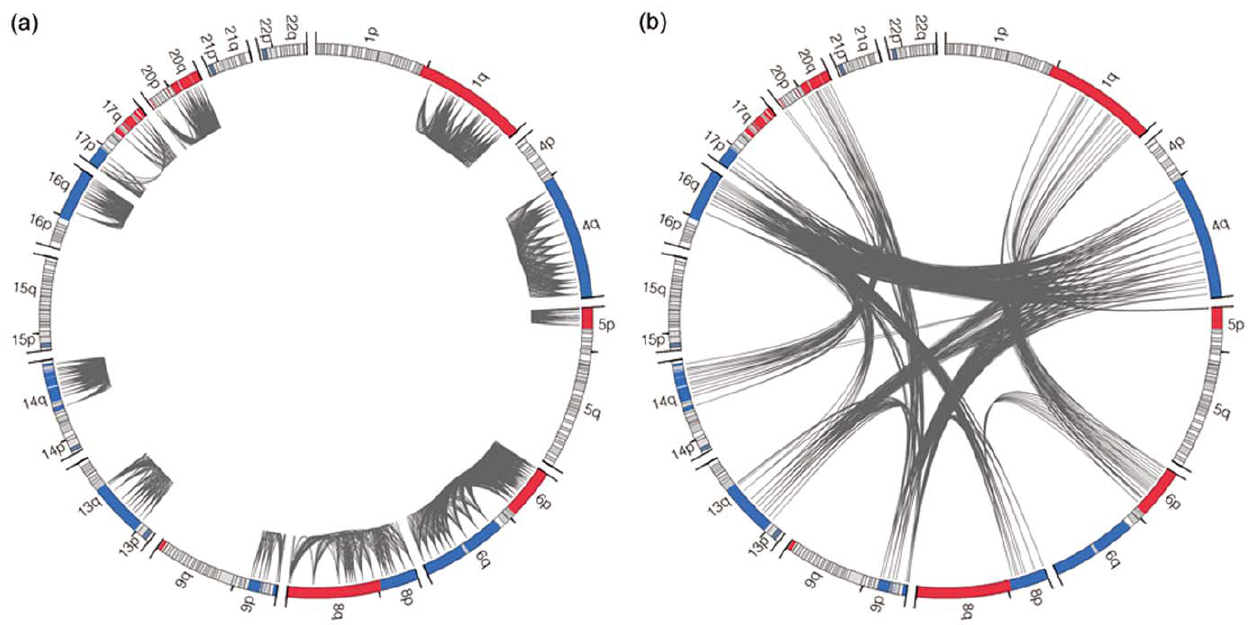
Figure 3. Correlations between significant chromosomal aberrations either located on the same (a) or different (b) chromosomes in all HCCs. Chromosomal segments with significant gain were highlighted in red and those with significant loss in blue. Spearman’s rank correlation coefficient was calculated to assess the correlations between different chromosomal copy number gains and losses at the significant level of p , 0.001.